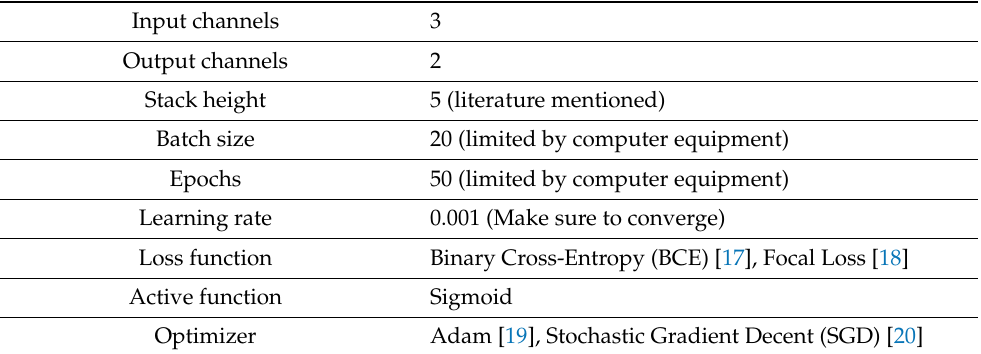
Table 2. Parameter settings of